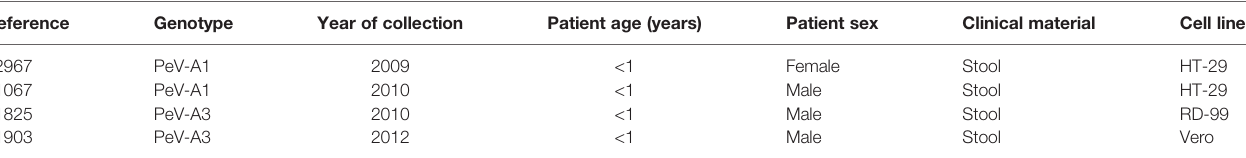
TABLE 1 | Clinical isolates used in the study.